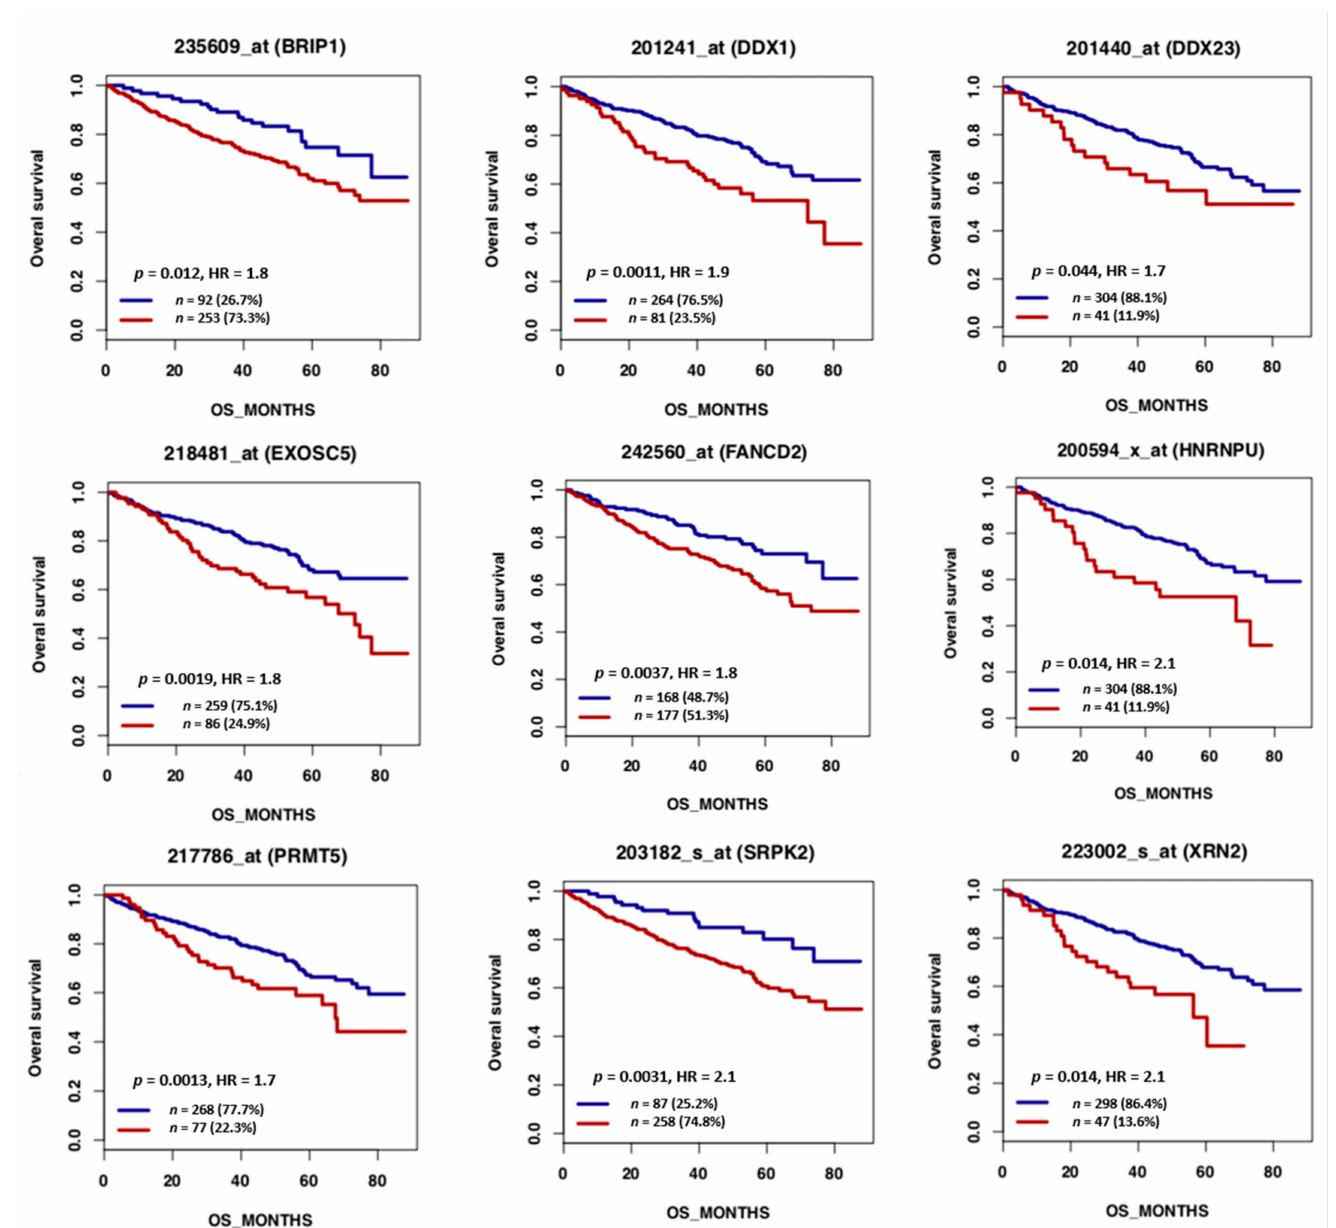
Figure 4. High expression of 9 TRCs resolution genes is associated with a poor outcome in MM patients. Patients of the TT2 cohort (Arkansas, newly diagnosed MM patients treated by High-dose therapy (HDT) and autologous stem cell transplantation (ASCT), n = 345) were ranked according to expression of the TRCs resolution genes and a maximum difference in OS was obtained using the Maxstat R function. Red: high expression. Blue: low expression. Kaplan– Meier curves were defined using GenomicScape web tool (http://www.genomicscape.com accessed on 23 July 2021). HR: hazard